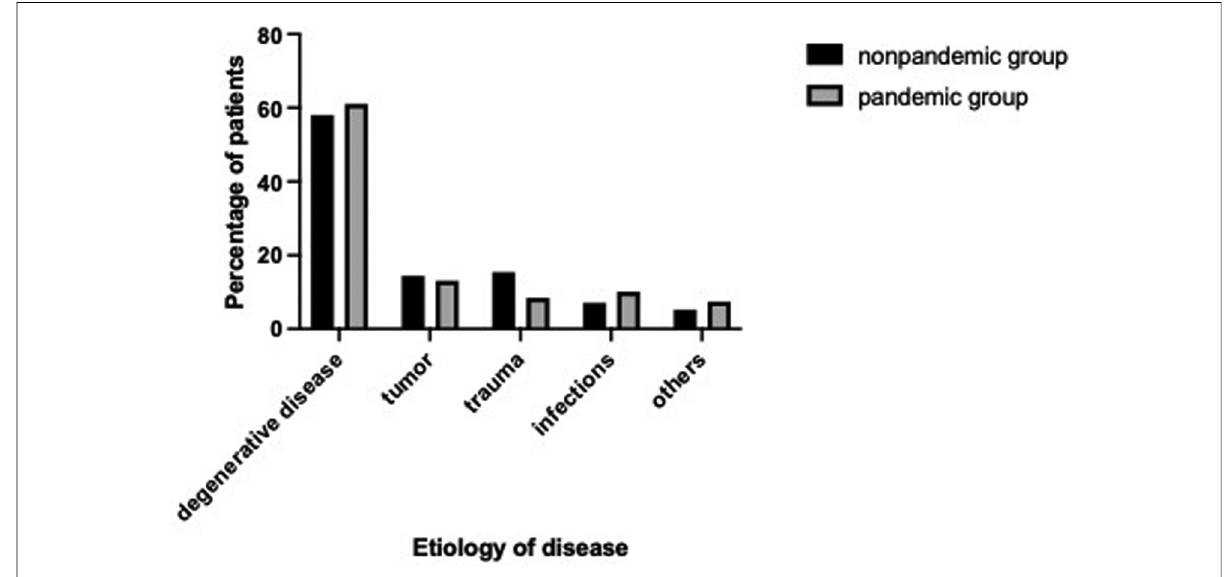
FIGURE 2 Distribution of disease etiology in non-pandemic and pandemic